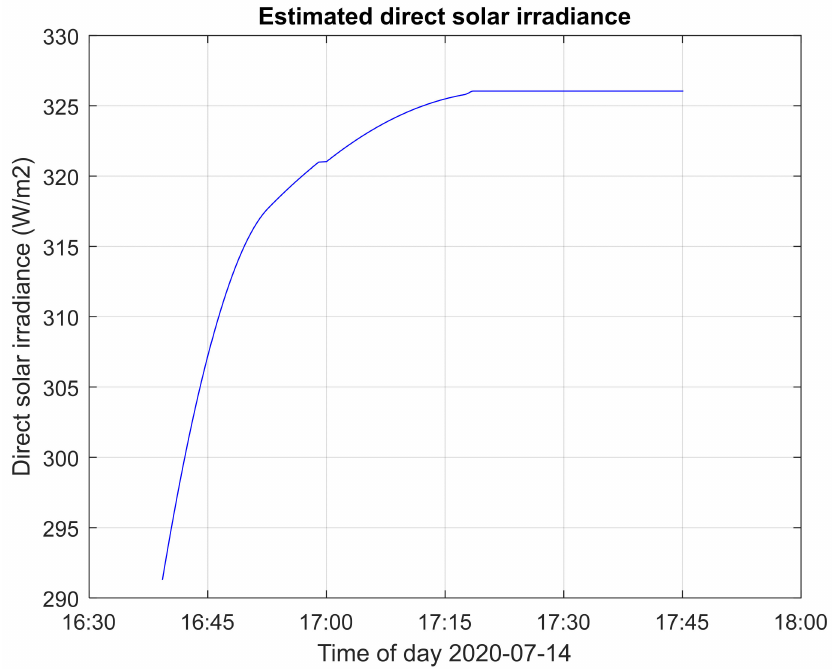
Figure 23. Predicted level of direct solar irradiance on 13 July 2020 from 16:40 until 17:45. Since the minimum-area bounding rectangle shape approximations were used for the cloud and solar contours, the algorithm proved to be very simple and requires an average time for estimating the sun coverage between 5 and 6 s. The simulations were run on a personal computer with the Intel Core i7-8750 processor (2.20 GHz) with 24 GB of RAM (1 GB was used for the integrated development environment for Java) with an SSD disk drive with sequential reading up to 2800